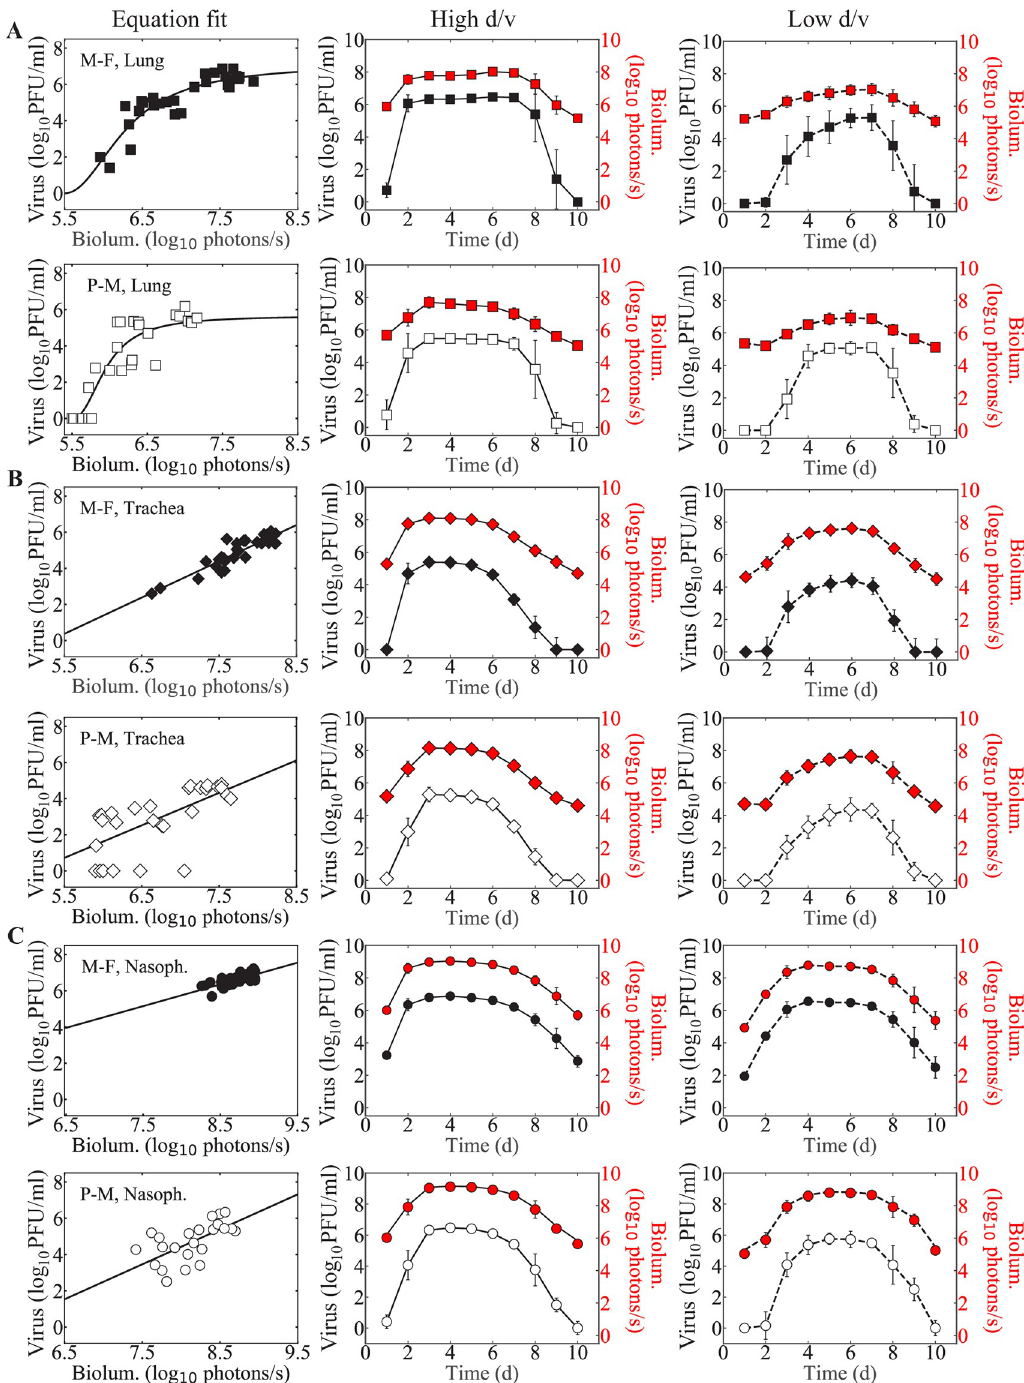
Fig 1. Translation of bioluminescence into viral loads. Fits of Eq (1) or Eq (2) to the paired bioluminescence and viral loads from the lung (Panel A), trachea (Panel B), or nasopharynx (Panel C) of individual mice at 3, 5, or 7 days after infection with low d/v or high d/v of rSeV-luc(M-F � ) virus (“M-F”, black) or rSeV-luc(P-M) virus (“P-M”, white). Correlation was derived for each compartment by combining the low d/v and high d/v infections for each strain. Estimated viral load time-series in the lung (Panel A, squares), trachea (Panel B, diamonds), and nasopharynx (Panel C, circles) for infection with rSeV-luc(M-F � ) (black) or rSeV- luc(P-M) (white) at high d/v (solid line) or low d/v (dashed line) from the bioluminescence (red). Data are shown as geometric mean ± standard deviation for 5 (paired data) or 15 mice per time point (time series data).